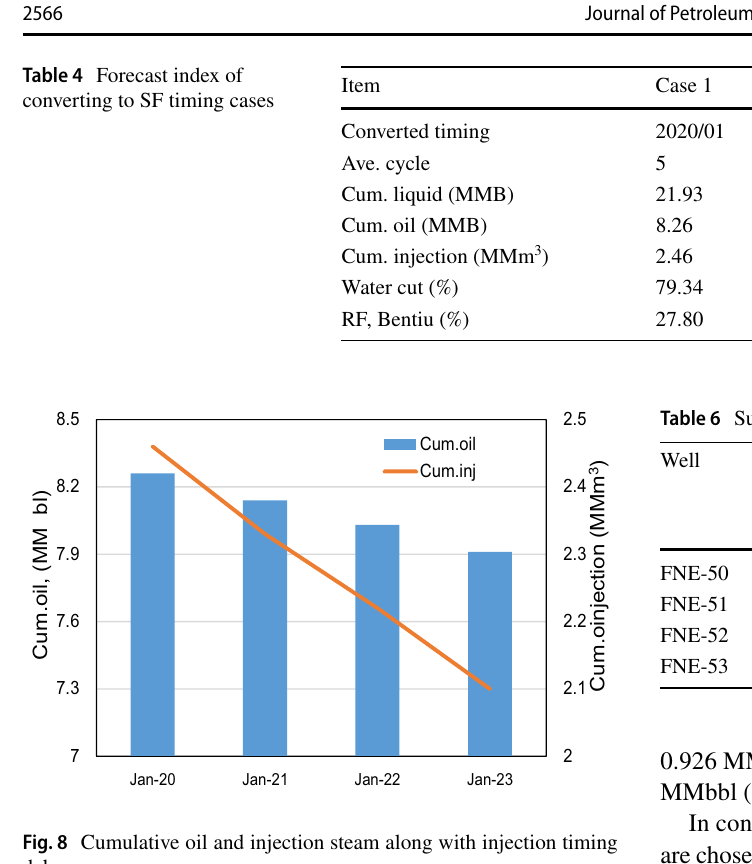
Fig. 8 Cumulative oil and injection steam along with injection timing delay Table 5 Summary of product intensity for producers Well